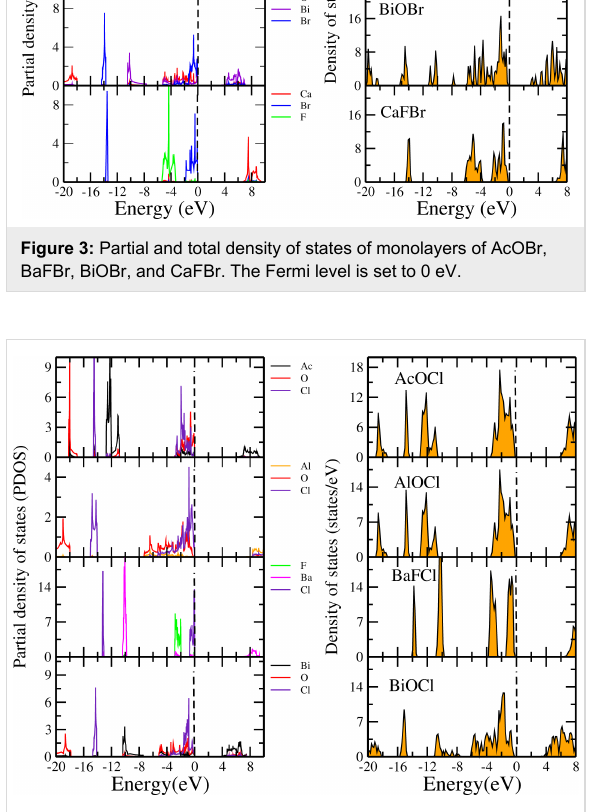
Figure 6: Partial and total density of states of monolayers of BiOI, LaOI, ScOI and YOI. The Fermi level is set to 0